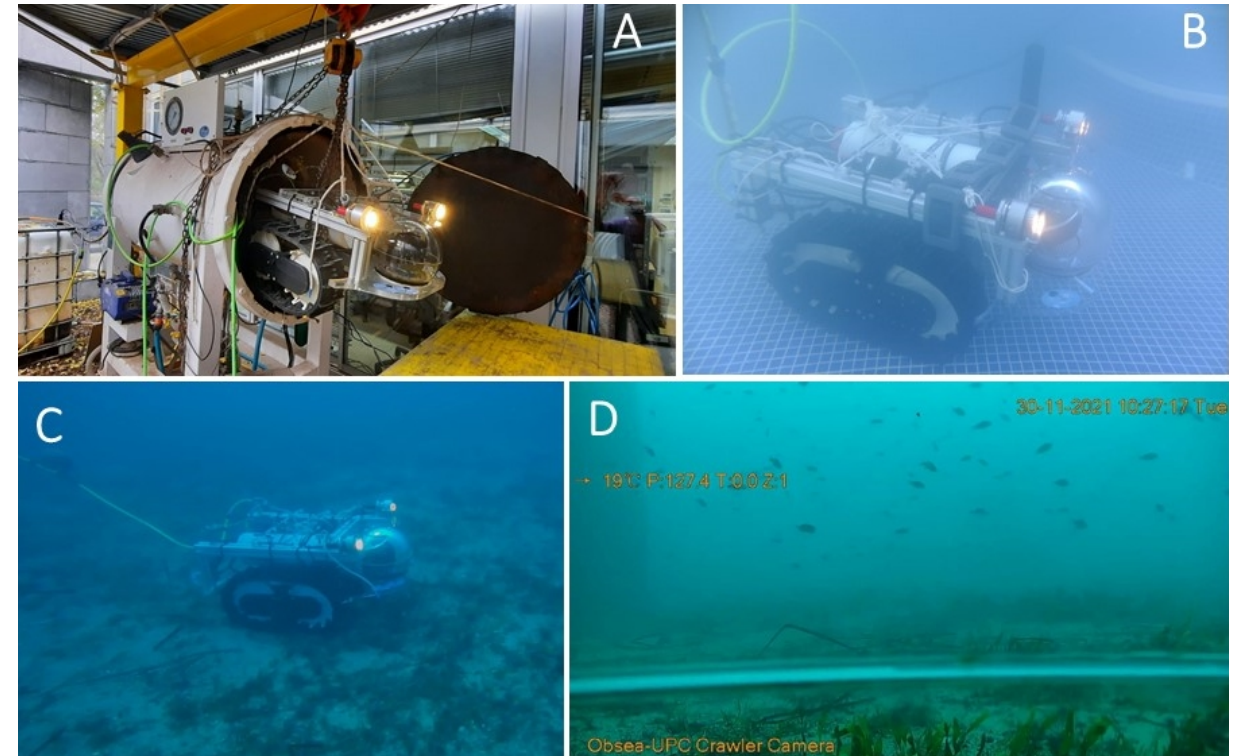
Figure 10. Different phases of the testing of the crawler: ( A ) in the hyperbaric chamber, ( B ) in the swimming pool of SARTI facilities, and ( C ) in the marine environment close to the OBSEA platform. The platform provided a vision of the marine seascape in remote mode ( D ) where the inferior part of the dome is visible, along with the timestamp coordinates.